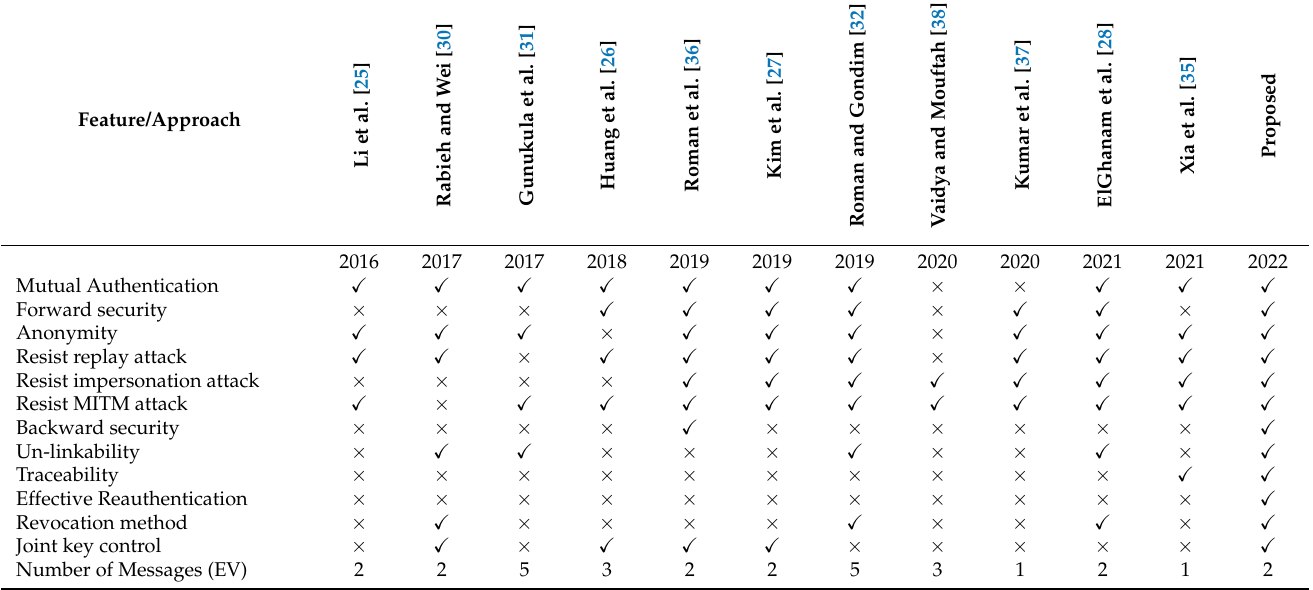
Table 4. Comparison of the proposed protocol’s security features with similar studies. Note: ” (cid:88) ” means “available”; “ × ” means “not available”.